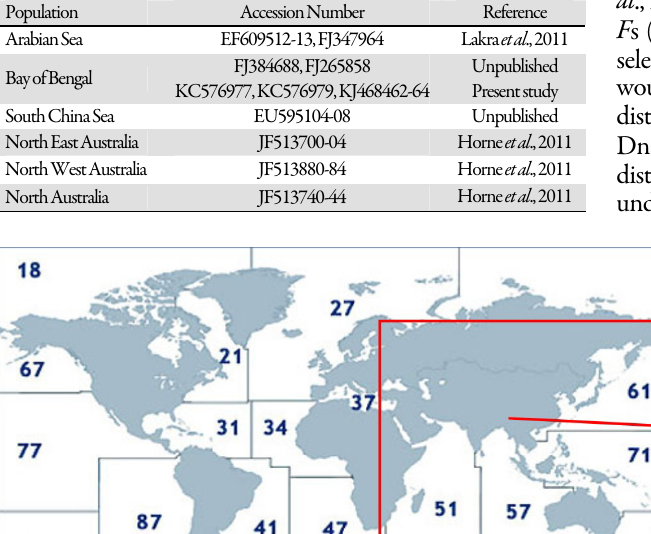
Table 1. COI sequence of E. tetradactylum used in this study Population Accession Number